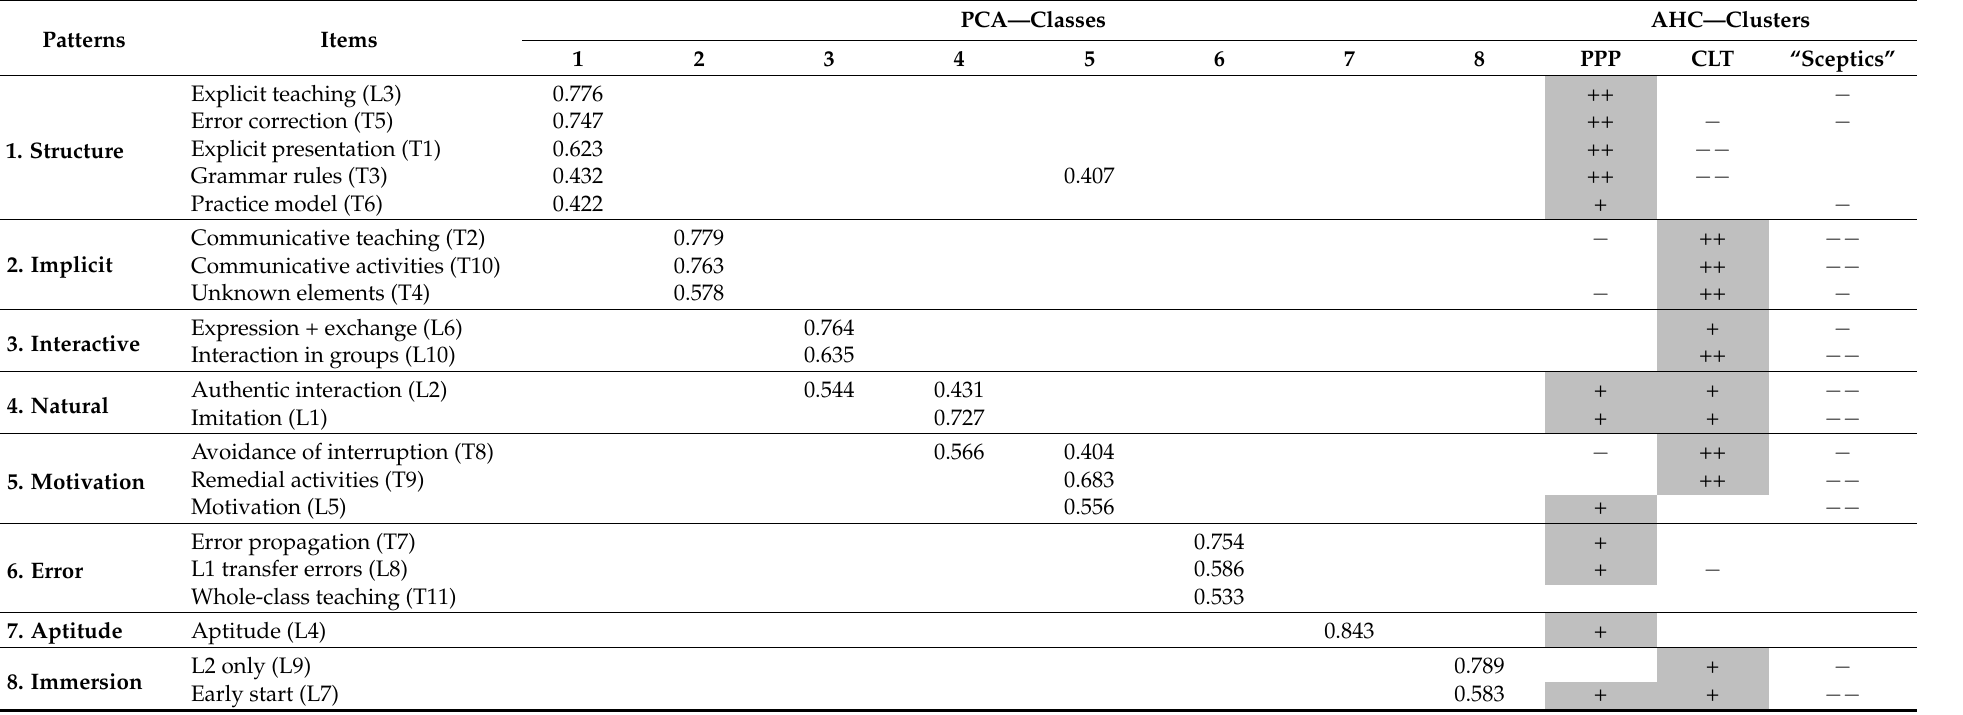
Table 3. Teaching and learning beliefs: principal components and